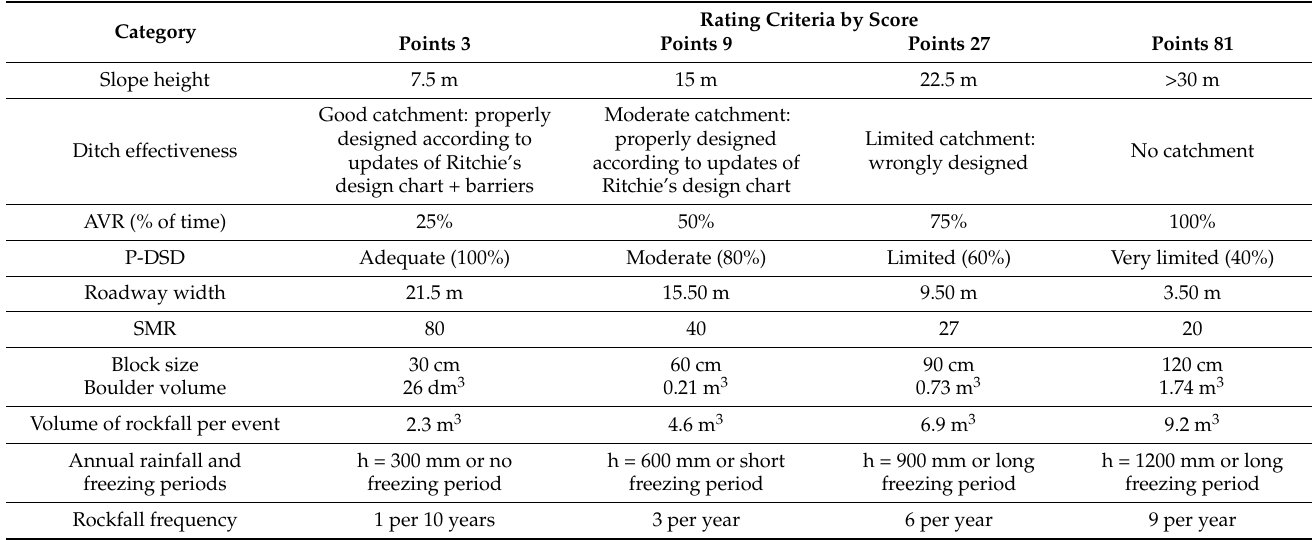
Figure 3. Schematization of the methodological approach carried out for this study. Table 1. Parameters taken into account by the modified Rockfall Hazard Rating System [8].